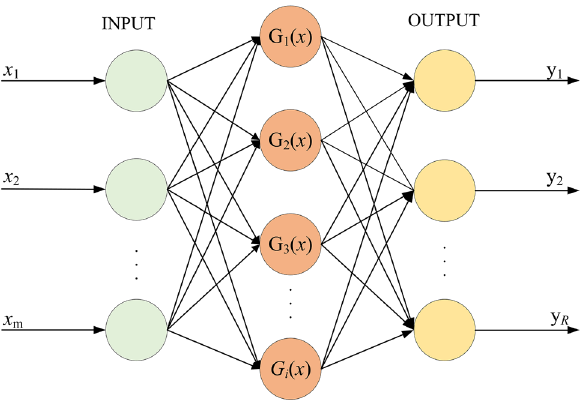
Figure 3. RBF neural network structure